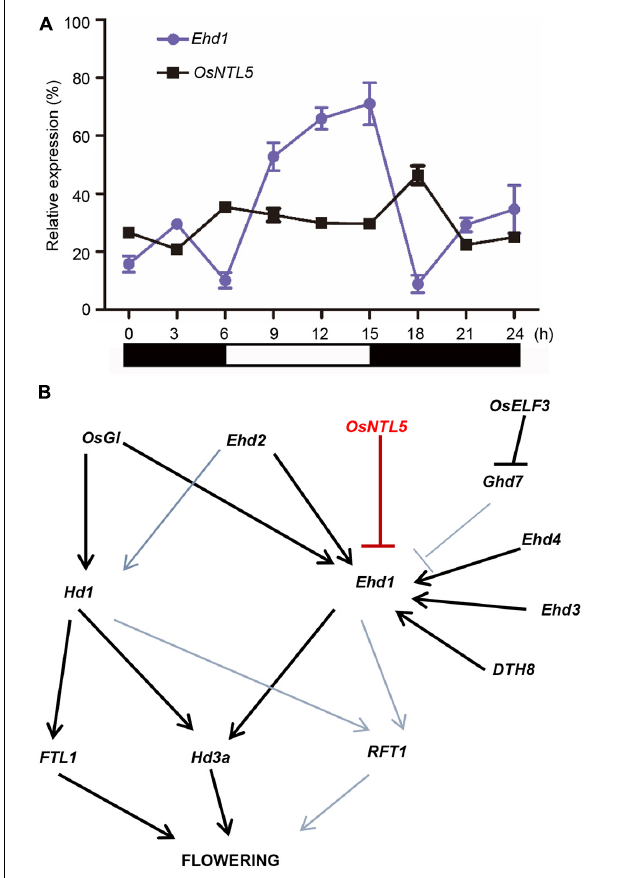
FIGURE 5 | Photoperiodic expression analysis of OsNTL5 and a working model of flowering regulation based on our findings in rice. (A) Ehd1 and OsNTL5 mRNA levels in WT (Nipponbare) under short day (SD) conditions. The black and white bars at the bottom represent the dark and light periods, respectively. The qRT-PCR experiments were performed in three biological replicates. The data were means ± SD (standard deviation) (B) Working model in rice flowering pathway of OsNTL5 as a modulator of Ehd1 expression and flowering repressor.